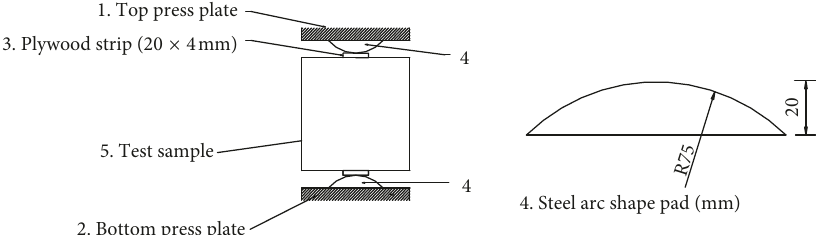
Figure 2: Dimensions and details of the typical splitting tensile test setup.